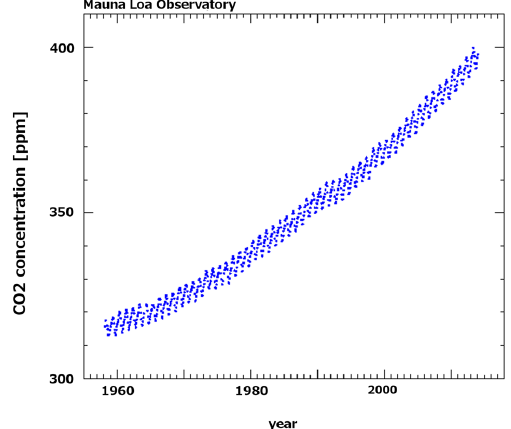
Figure 1. Atmospheric CO 2 concentrations recorded at Mauna Loa Observatory between 1958 and 2014. Due to human-produced emissions, CO 2 levels in Earth’s atmosphere have been rapidly ris- ing since the beginning of the Industrial Revolution and nowadays are crossing 400ppm (400.01ppm on 25 May 2013), equalling a 44% increase when compared to pre-industrial CO 2 concentra- tions of around 278ppm. Source: Dr Pieter Tans, NOAA/ESRL (http://www.esrl.noaa.gov/gmd/ccgg/trends) and Dr Ralph Keeling, Scripps Institution of Oceanography